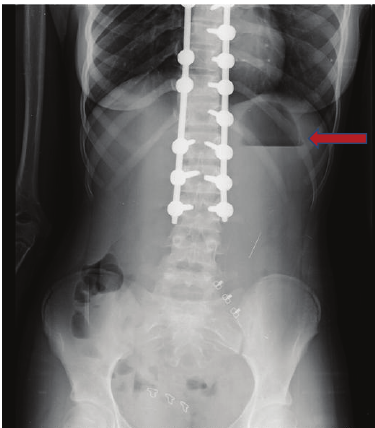
Figure 2: Air-fluid level in the